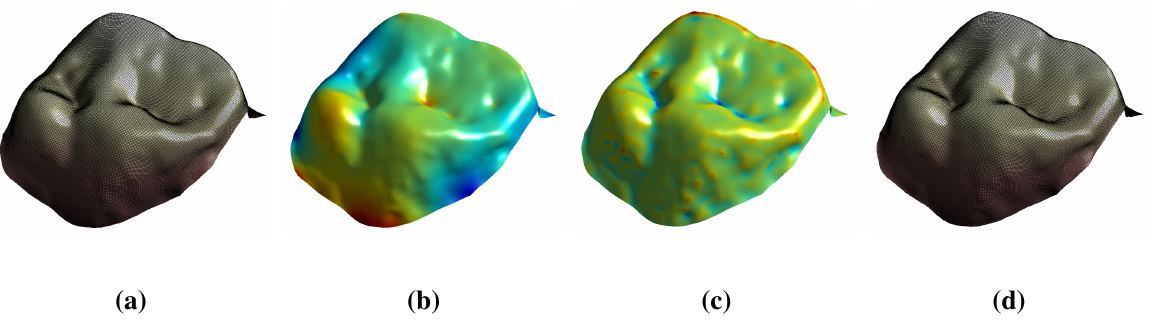
Figure 5. ( λ, H ) reconstruction of surfaces. ( a ) The original mesh of a partition of the Buddha surface. We reconstruct the surface using the corresponding λ and H in ( b ). ( c ) The original mesh of another human face surface. By using λ and H , we can reconstruct the face, as shown in ( d ).